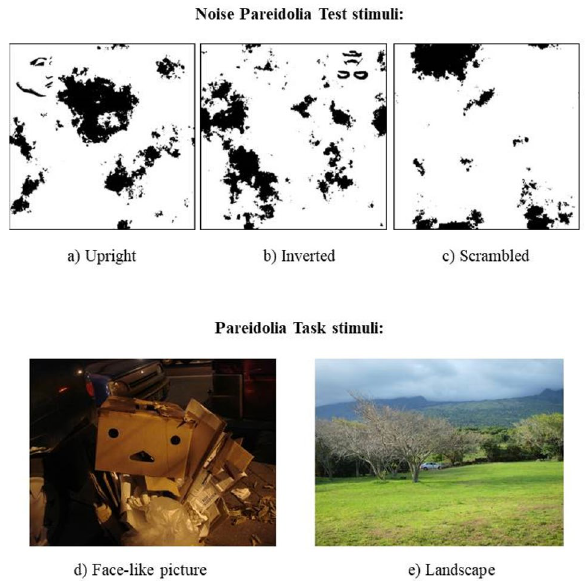
Figure 4. Sample stimuli from the Noise pareidolia test and Pareidolia task. Upper part of the figure: upright ( a ), inverted ( b ), and scrambled ( c ) stimuli from the Noise Parediolia test 53 . Bottom part of the figure: sample Face-like picture ( d ) and landscape ( e ) from the Pareidolia